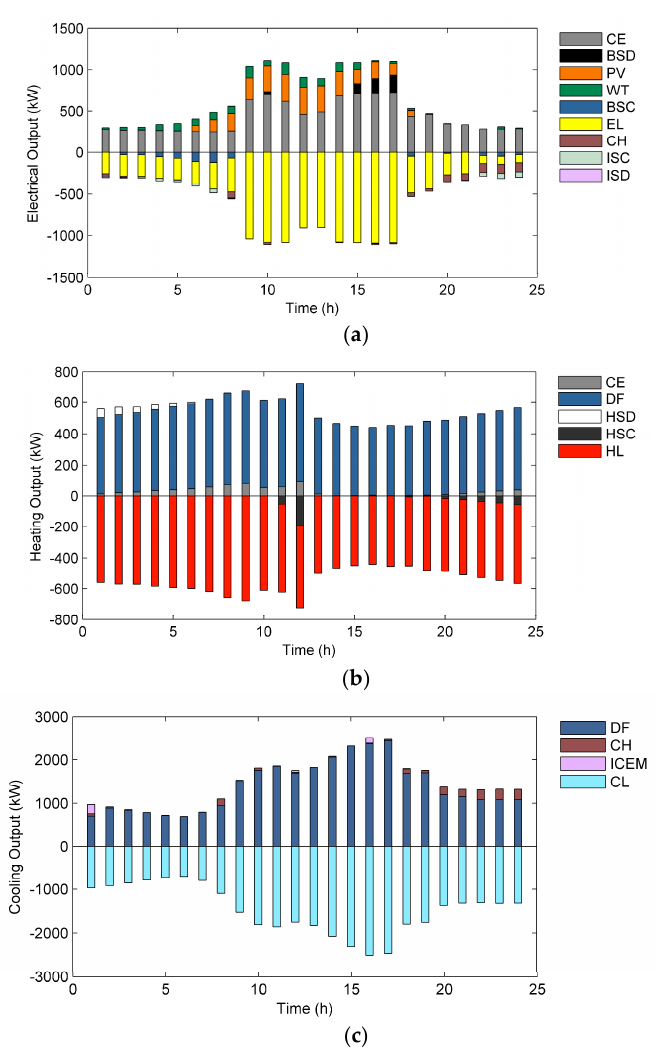
Figure 7. Optimal outputs of MEG in Scenario 1. ( a ) The optimal electrical outputs; ( b ) The optimal heating outputs; and, ( c ) The optimal cooling outputs.